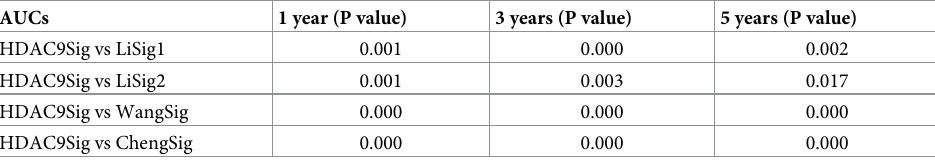
ROC, receiver operating characteristics; AUC, area under the curve; HDAC9, histone deacetylase 9; Sig,